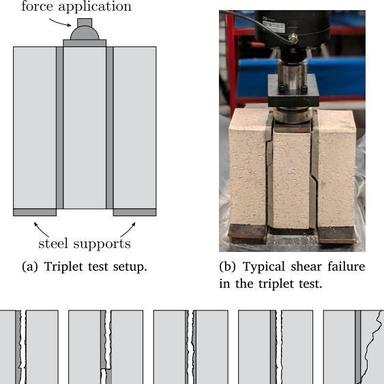
Triplet test setup, typical failure and brick failure modes.